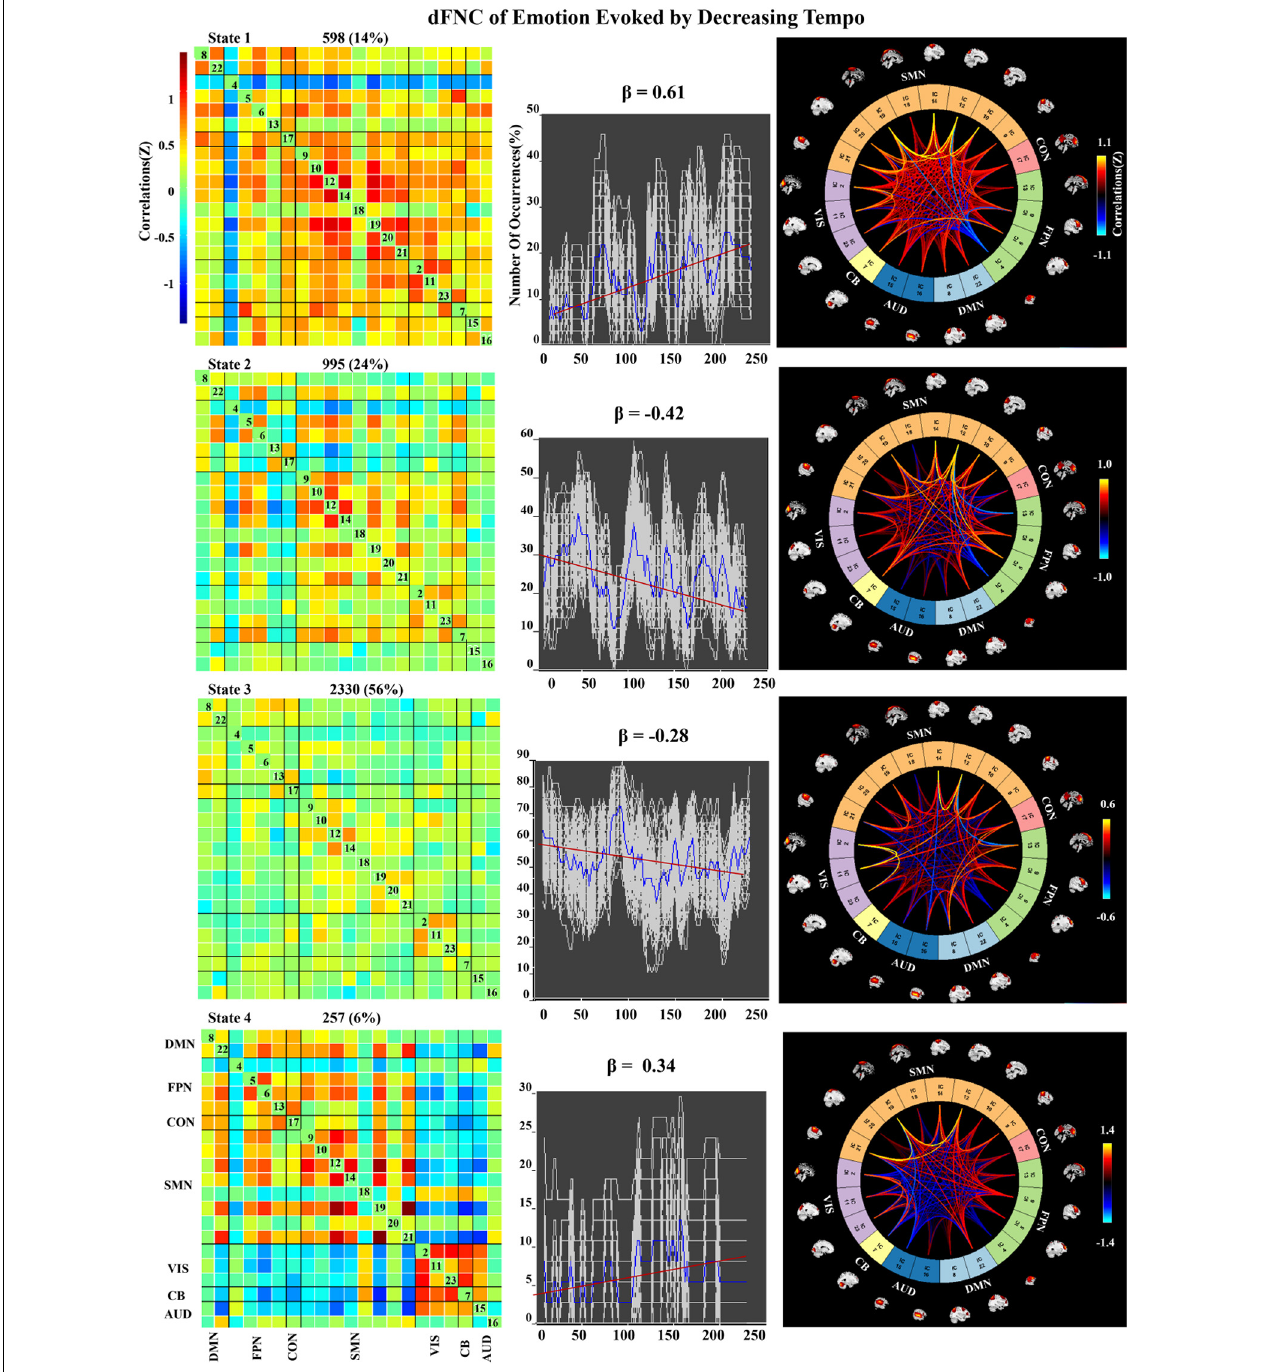
FIGURE 7 | Correlation matrix, number of occurrences, and connectograms of four clusters of evoked emotion by decreasing -tempo music.